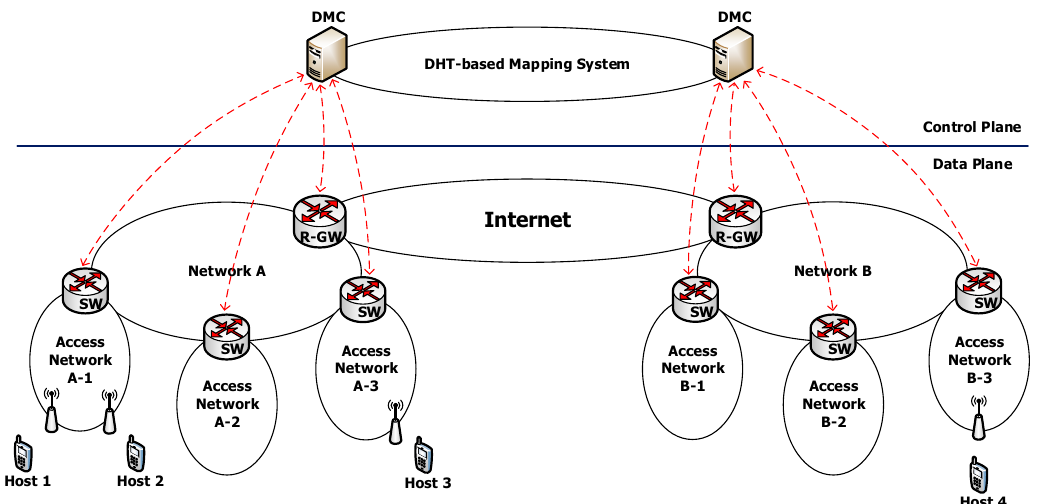
Figure 3. Distributed host identifier–locator (HID–LOC) mapping management in Mobile-Oriented Future Internet (MOFI) architecture.